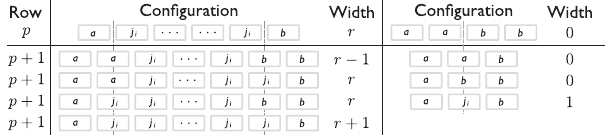
FIG. 18. The recursive rules for enumerating the p þ 1 th row of the leading-order diagrams given the p th row of the leading-order diagram. These rules are derived from the fact that, in a leading diagram, the difference between the DW positions at even row p and odd row p þ 1 is exactly one lattice